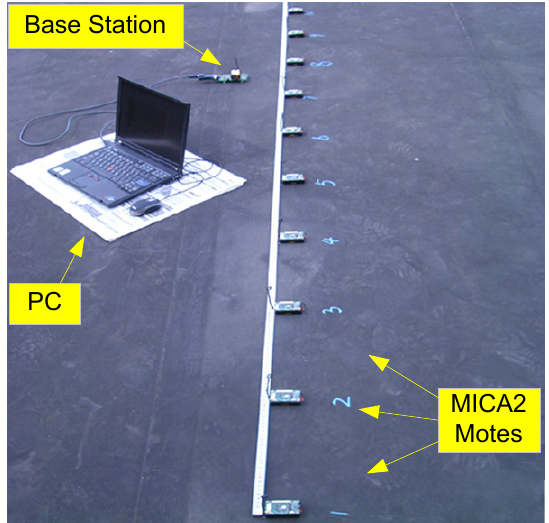
Figure 3. Experimental